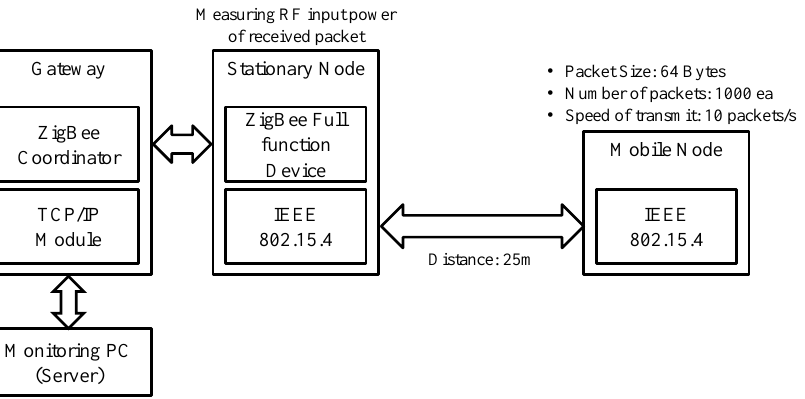
Figure 9. Experimental setup used to evaluate the successful packet transfer rate and RF input